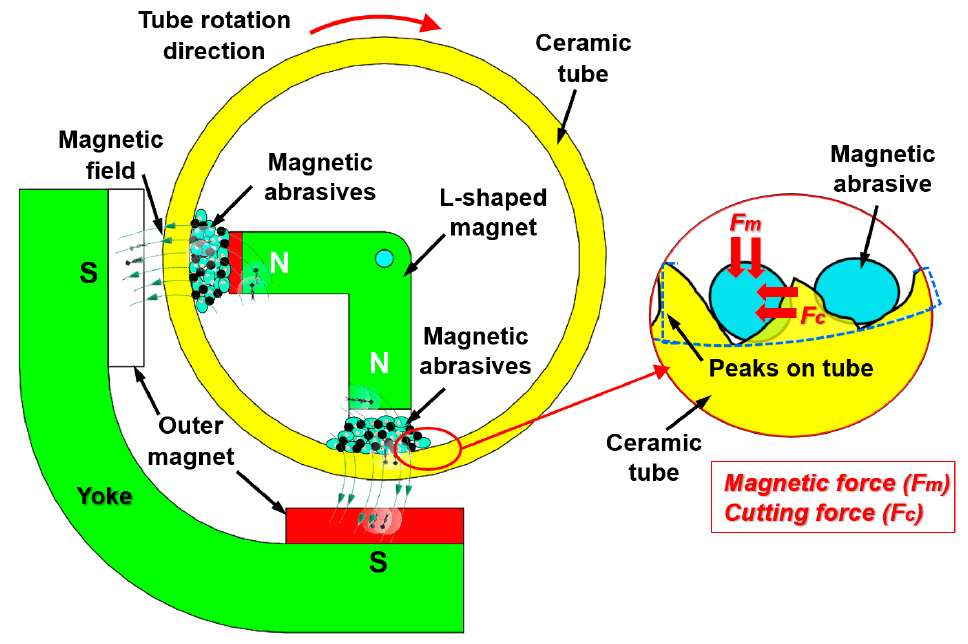
Figure 7. Front view of internal MAF process for the surface finishing of alumina ceramic tube, redrawn from Yun et al. [55].